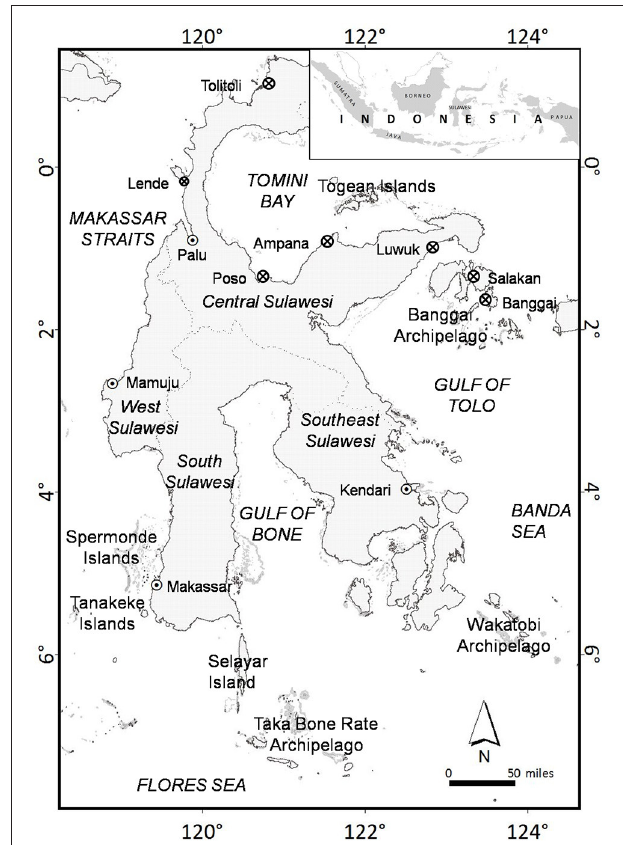
FIGURE 1 | Map of Sulawesi showing provincial boundaries, sea areas and small island